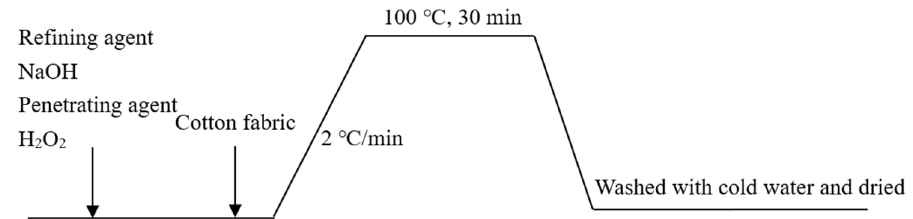
Figure 2. Pretreatment process of polyester. 2.3. UV Resistance Test The fabrics for the test were coated with the absorbent by impregnation method. The weight of fabric used was 1.0 g, and the absorbent solutions prepared were 0, 10 − l , 5.0 × 10 − 4 , and 2.5 × 10 − 4 mol of each of the prepared compound in 50 mL of anhydrous ethanol. The fabric was soaked in one of the above solutions at room temperature for 1 h. The fabric was fully soaked before the test. For full coating of the UV absorbent, the fabrics were taken out, and after natural drying, went through the coating procedure for a total of three times (disposable gloves were used). The fabric coated with UV absorbent was cut into the required round shape and tested. 2.4. Dyeing Rate Test First, 0.01 mmol of UV absorbent was accurately weighed and dissolved (with shak- ing) in 100 mL of anhydrous ethanol. Then, 2.0, 4.0, 6.0, 8.0, and 10.0 mL of the prepared UV absorbent solution was separately transferred to a 50 mL volumetric flask and made up to 50 mL with anhydrous ethanol. Taking anhydrous ethanol as the standard solution, the scanning wavelength range from 200 to 400 nm was obtained. 3. Results and Discussion 3.1. Effects of Substituents on UV Spectra of 2,4-Dihydroxy Dibenzophenone The UV absorption spectra of the nine compounds were collected at room tempera- ture on a UV-1800 UV-vis spectrometer having 2,4-dihydroxy dibenzophenone in a con- centration range of 10 − 3 to 10 − 5 mol/L. The ethanol used in the experiments was of spectro- scopic grade purchased from Aladdin Industrial Corporation (Shanghai, China) and was used as purchased. The ultraviolet spectra are shown in Figure 3. For comparison pur- poses the maximum absorbance is normalized for all measurements.